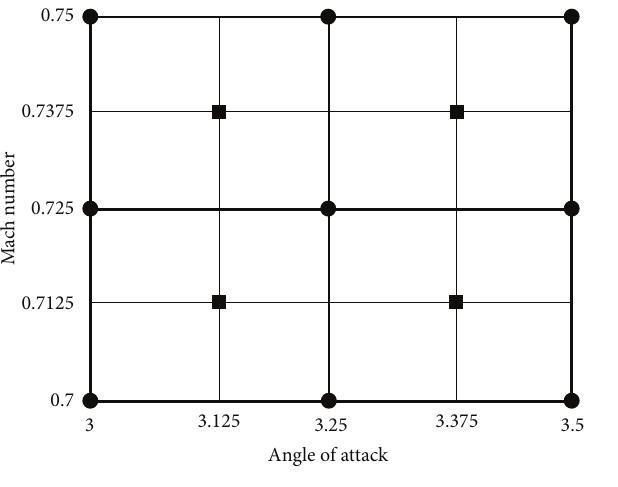
Figure 2: Lattice of snapshots.